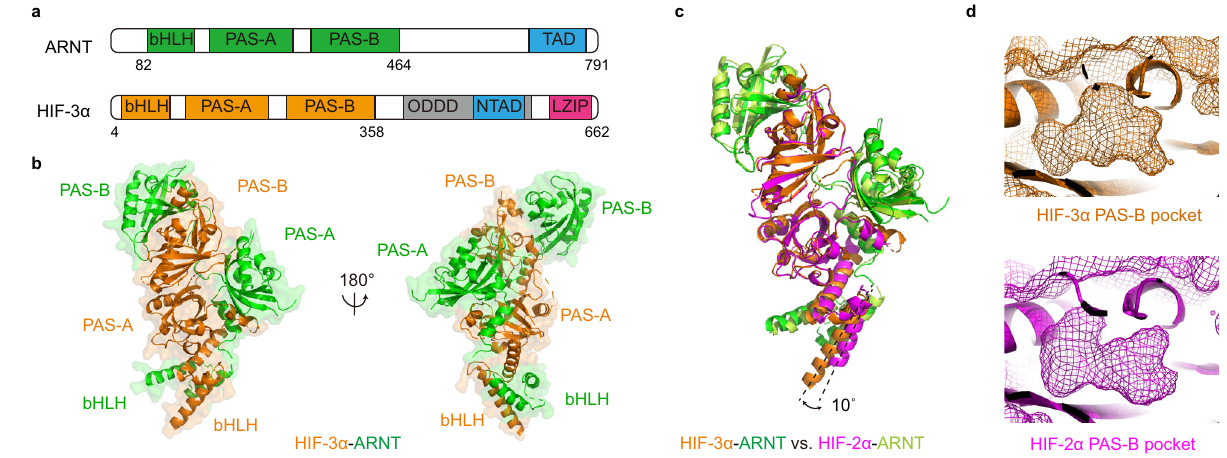
Fig. 1 Crystal structure of the HIF-3 α -ARNT heterodimer in apo form. a Schematic representation showing the domain arrangements of ARNT and HIF- 3 α . bHLH basic helix-loop-helix, PAS PER-ARNT-SIM, ODDD oxygen-dependent degradation domain, TAD transactivation domain, LZIP leucine zipper. b Overall structure of the HIF-3 α -ARNT heterodimer in two views with all domains labelled. HIF-3 α and ARNT are colored in orange and green, respectively. c Structure superimposition of HIF-3 α -ARNT and HIF-2 α -ARNT. d The shape of empty PAS-B cavities of HIF-3 α (orange) and HIF-2 α (magenta) shown in